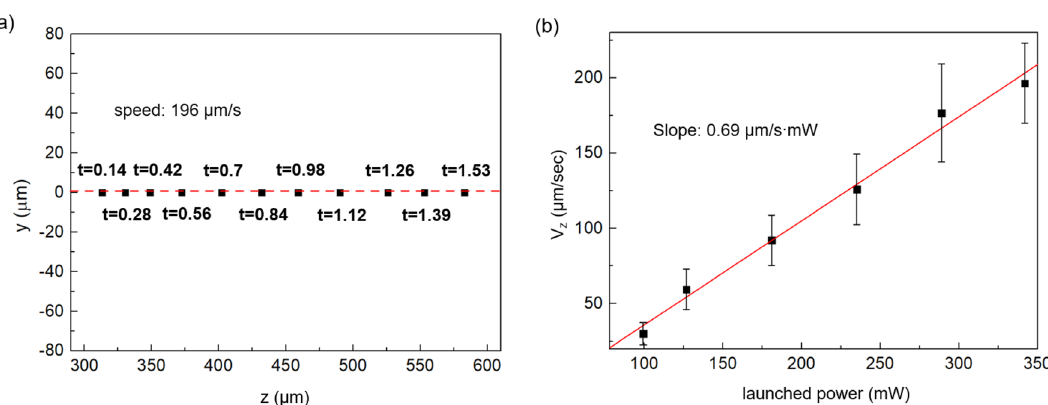
Figure 3. ( a ) The motion of a single polystyrene bead trapped and transported by a single Bessel-like beam in the water. The bead’s transverse position is on the y-axis while the axial position is on the z-axis. The data were taken at an elapsed time t . ( b ) The transportation speed along the axial direction, V z, as a function of launched laser